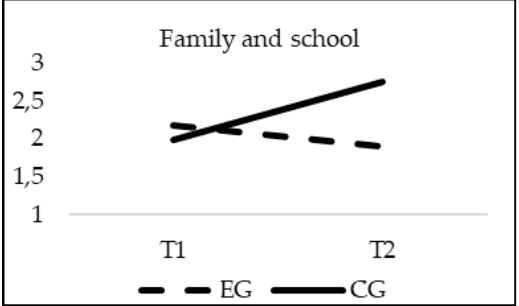
Figure 9. Interaction effects of group (EG-CG) and time (T1-T2) in Communication between family